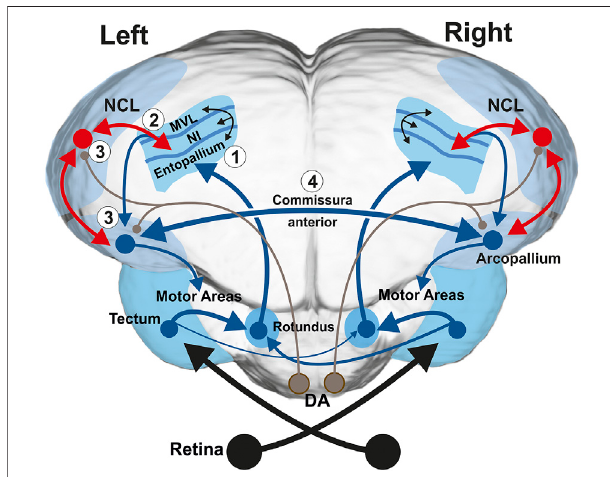
FIGURE 1 | Schematic frontal depiction of the tectofugal visual system along with the anterior commissure, the projection of the tectofugal system to the prefrontal-like nidopallium caudolaterale (NCL) and the projection of NCL onto the motor arcopallium (A). The subsystems that play key roles for the present study are depicted in red. The tectorotundal axons have a larger number of fi bers that cross from right to left, thereby constituting a more bilateral representation of visual information in the left hemisphere. In the current study, we recorded the activity patterns of single NCL neurons. The NCLreceivesinputfromthetectofugalsystemviathenidopalliumintermediale (NI) and feedback projections from the arcopallium. In addition, dopaminergic (DA) brainstem projections (depicted in brown color) can modify visuo- associative and visuo-motor connections in experience dependent manner. Numbers 1 – 4 refer to the four steps of the working hypothesis on lateralized visual discrimination learning and taskexecution at pallial level inbirds. Further abbreviation: mesopallium ventrolaterale